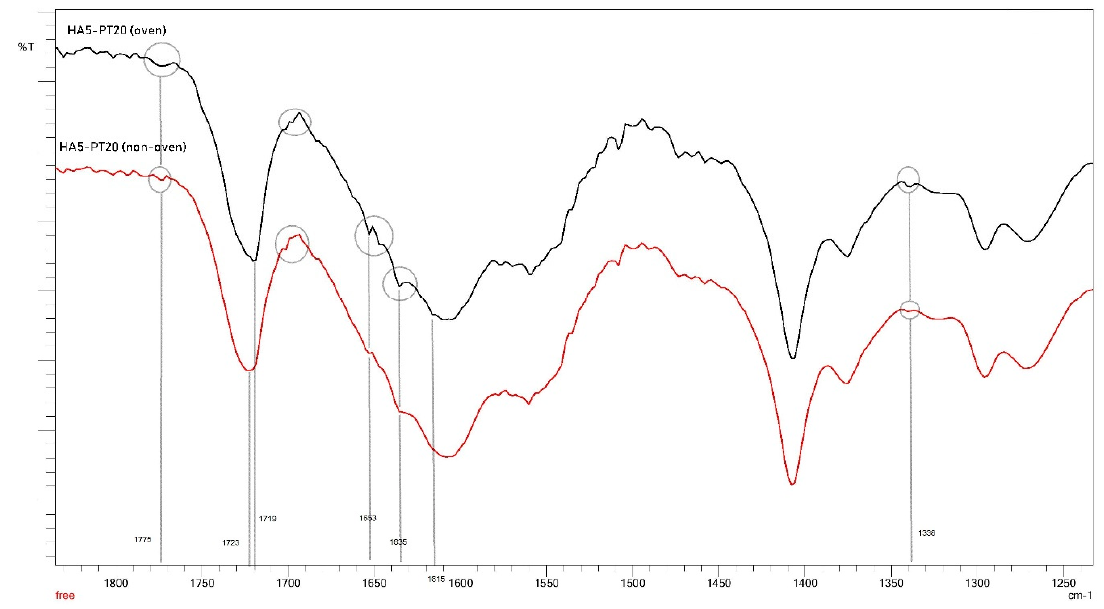
Figure 14. HA5-PT20 before and after crosslinking by oven-assisted thermal method (x-axis is the wavenumber / cm − 1 ).